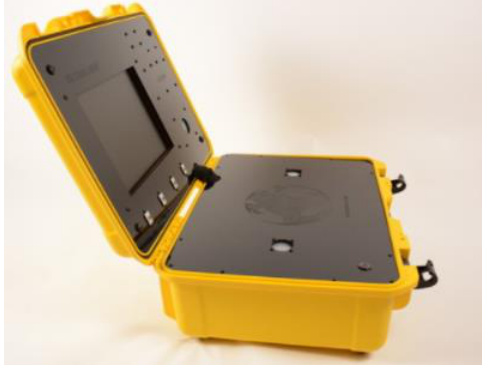
Fig. 2. The view of AxionR/S+ Table 2. AxionR/S+ device technical data